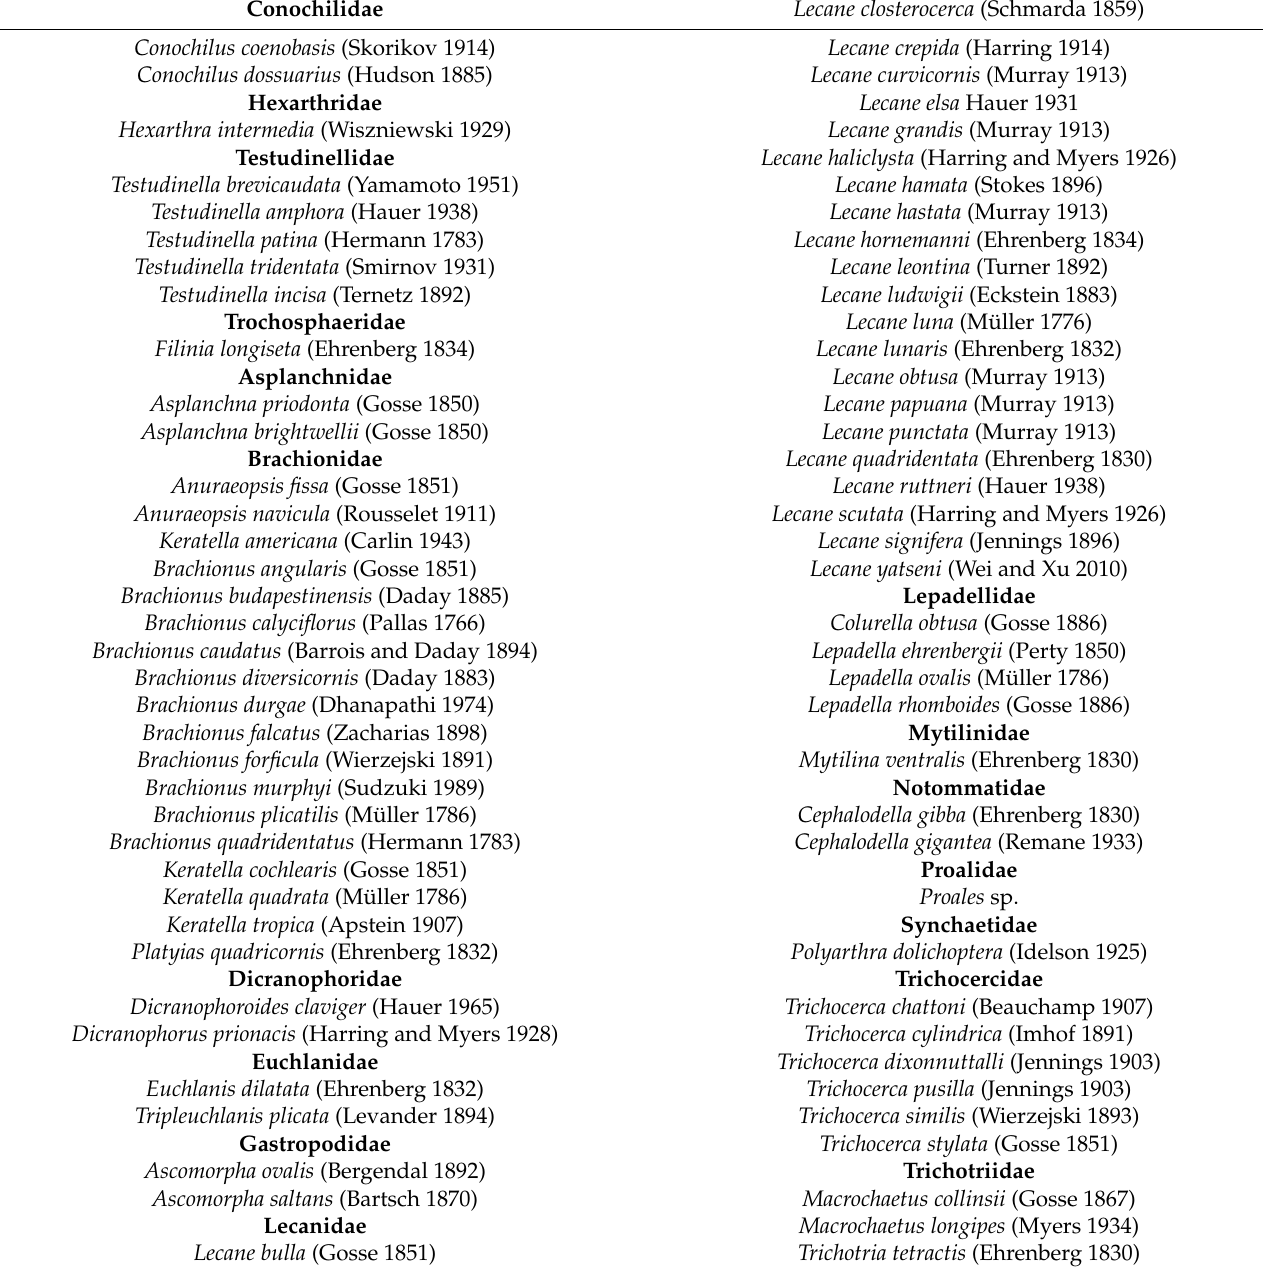
Table 2. Systematic list of the Rotifera species in freshwater habitats in Da Nang City, central